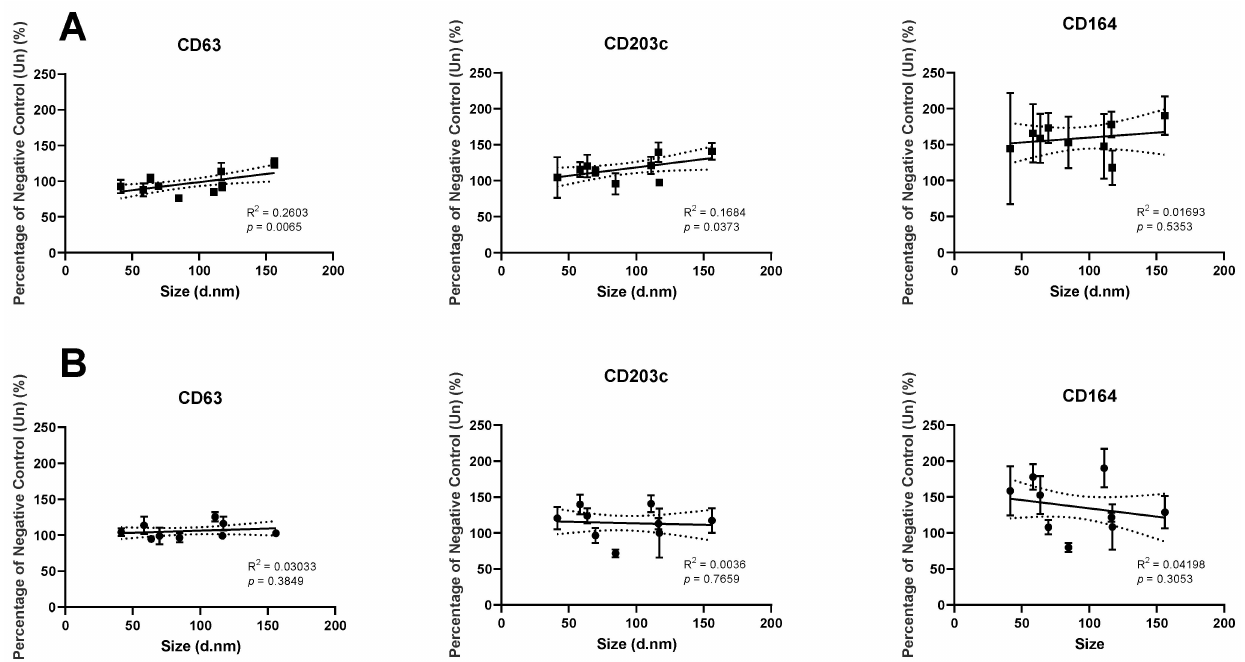
Figure 10. The relationship between liposome size and the resultant expression profile following incubation for 4 h ( A ) or 24 h ( B ). Mean values calculated from n =